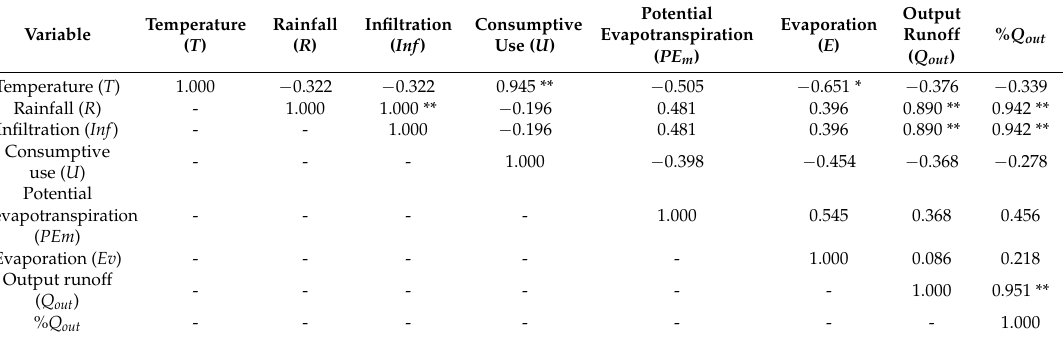
Table 3. Diagonal matrix of Pearson correlations ( r ) of the hydrological variables of